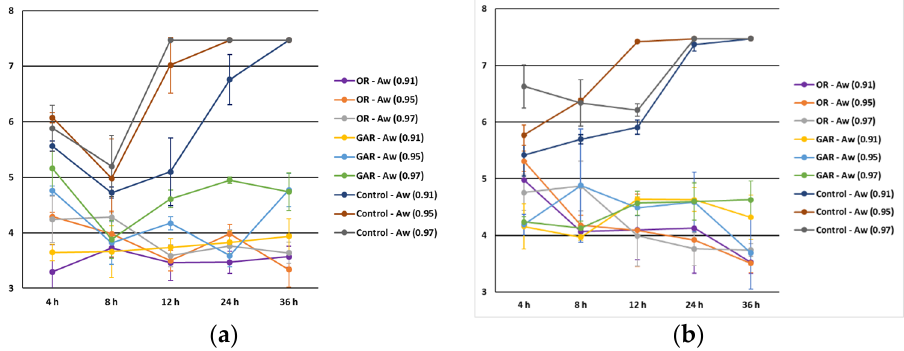
Figure 3. Influence of a w level on the antimicrobial effect of oregano (OR) and garlic (GAR) essential oils against Salmonella spp. ( a ) and Listeria monocytogenes ( b ).